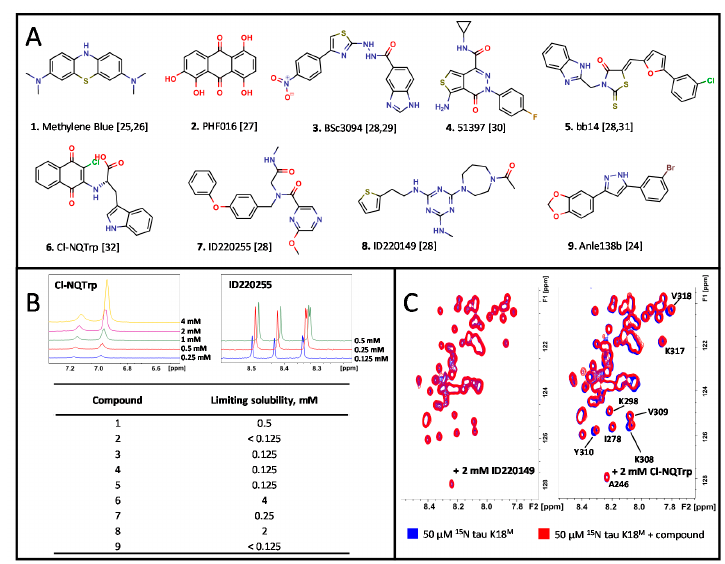
Figure 1. Literature ligand NMR titration assay against tau K18 M . ( A ) Chemical structures of the ligands (CPK colouring scheme). ( B ) An example of 1D 1 H NMR spectra during titration of Cl-NQTrp and ID220255 as determined by 1D 1 H NMR with determined ligand solubilities. ( C ) The 2D [ 1 H- 15 N] SF-HMQC spectra of a non-binder ID220149 (2 mM) (Left) and a binder Cl-NQTrp (2 mM) (Right).